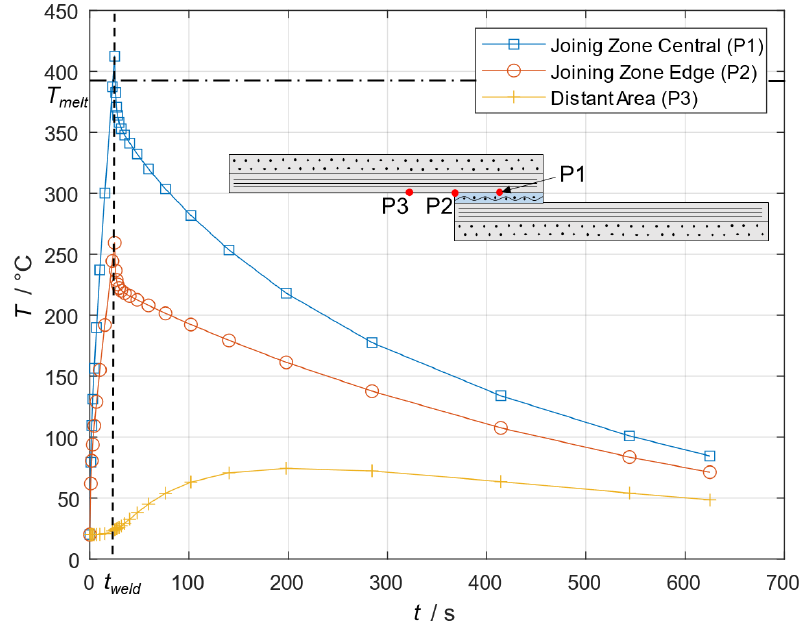
Figure 3. Transient temperature data at selected elements resulting from the modeled resistance welding process for an input power of 60 kW/m 2 .